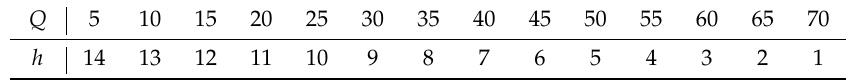
Table 3. The Q values and the corresponding hierarchical level values of h used in the SRM, and H = 15. Q